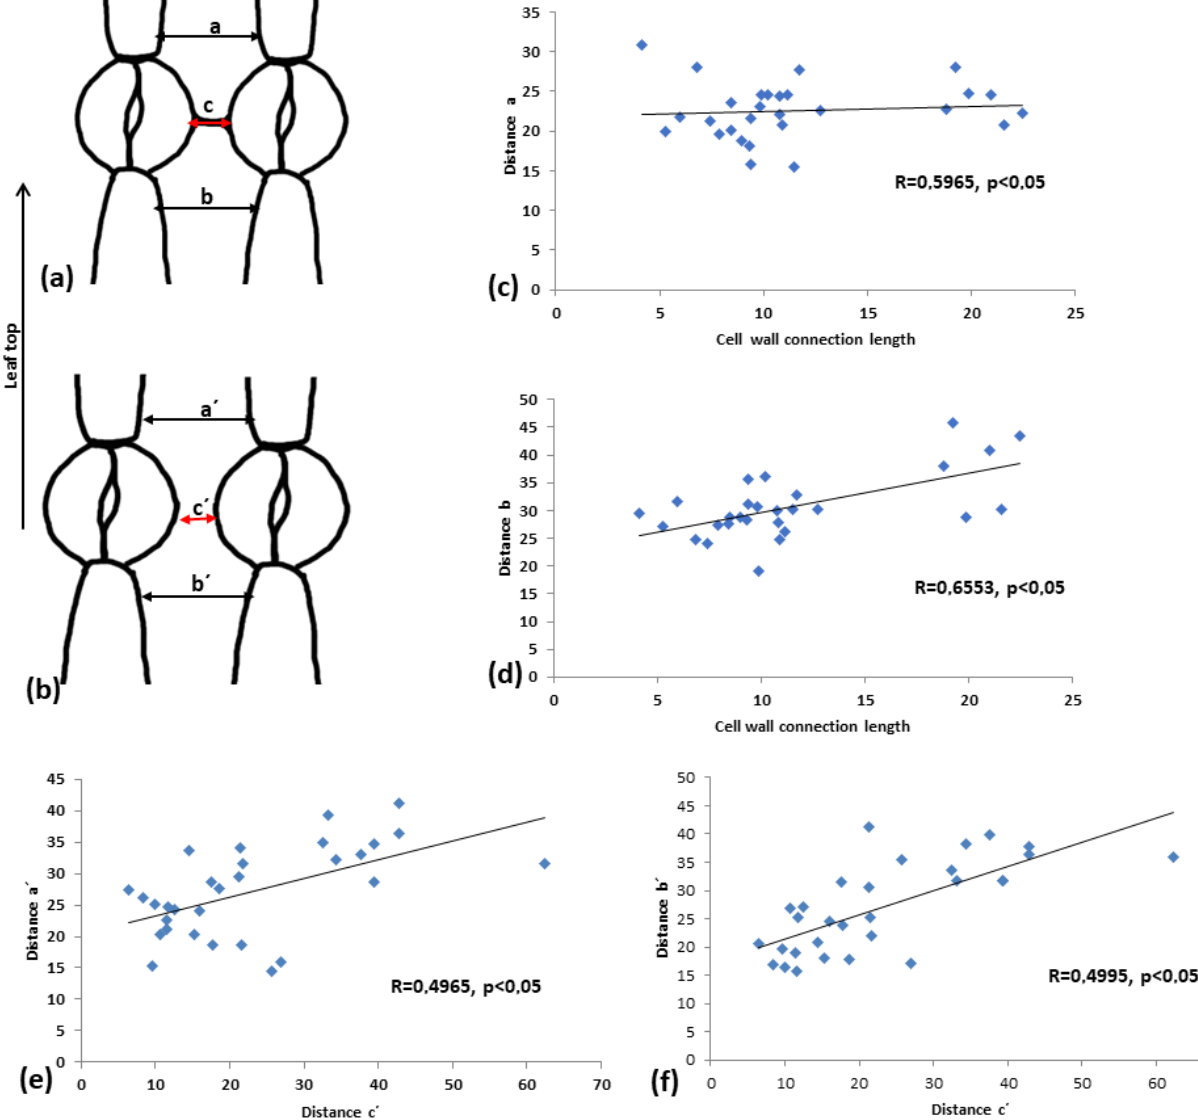
Figure 12. Comparison of the distance, as shown in ( a , b ), between connected vs. unconnected adjacent stomata. ( c , d ) Diagrams for connected adjacent stomata, ( e , f ) diagrams for unconnected adjacent stomata. ( c , e ) Diagrams showing the correlation between the distance c (cell wall connection length, in the case of connected stomata) to the distance a. ( e , f ) Correlations between distances a’ and b’ to distance c’. Every result is statistically significant at p < 0.05, and the calculated R coefficient is depicted on the graphs. Mean values from 100 stomata pairs are presented.